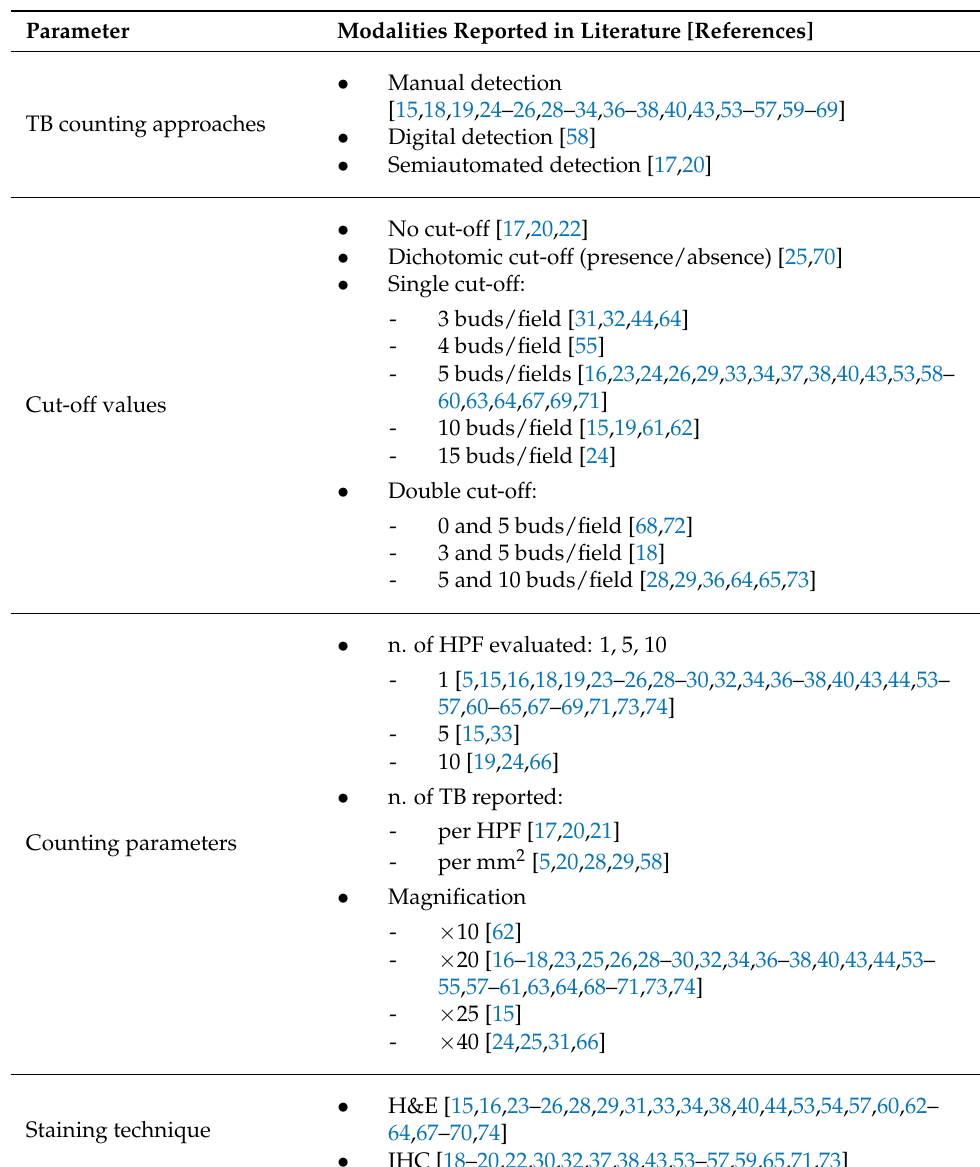
Table 1. Parameters and modalities of TB evaluation in Oral Squamous Cell Carcinoma explain in